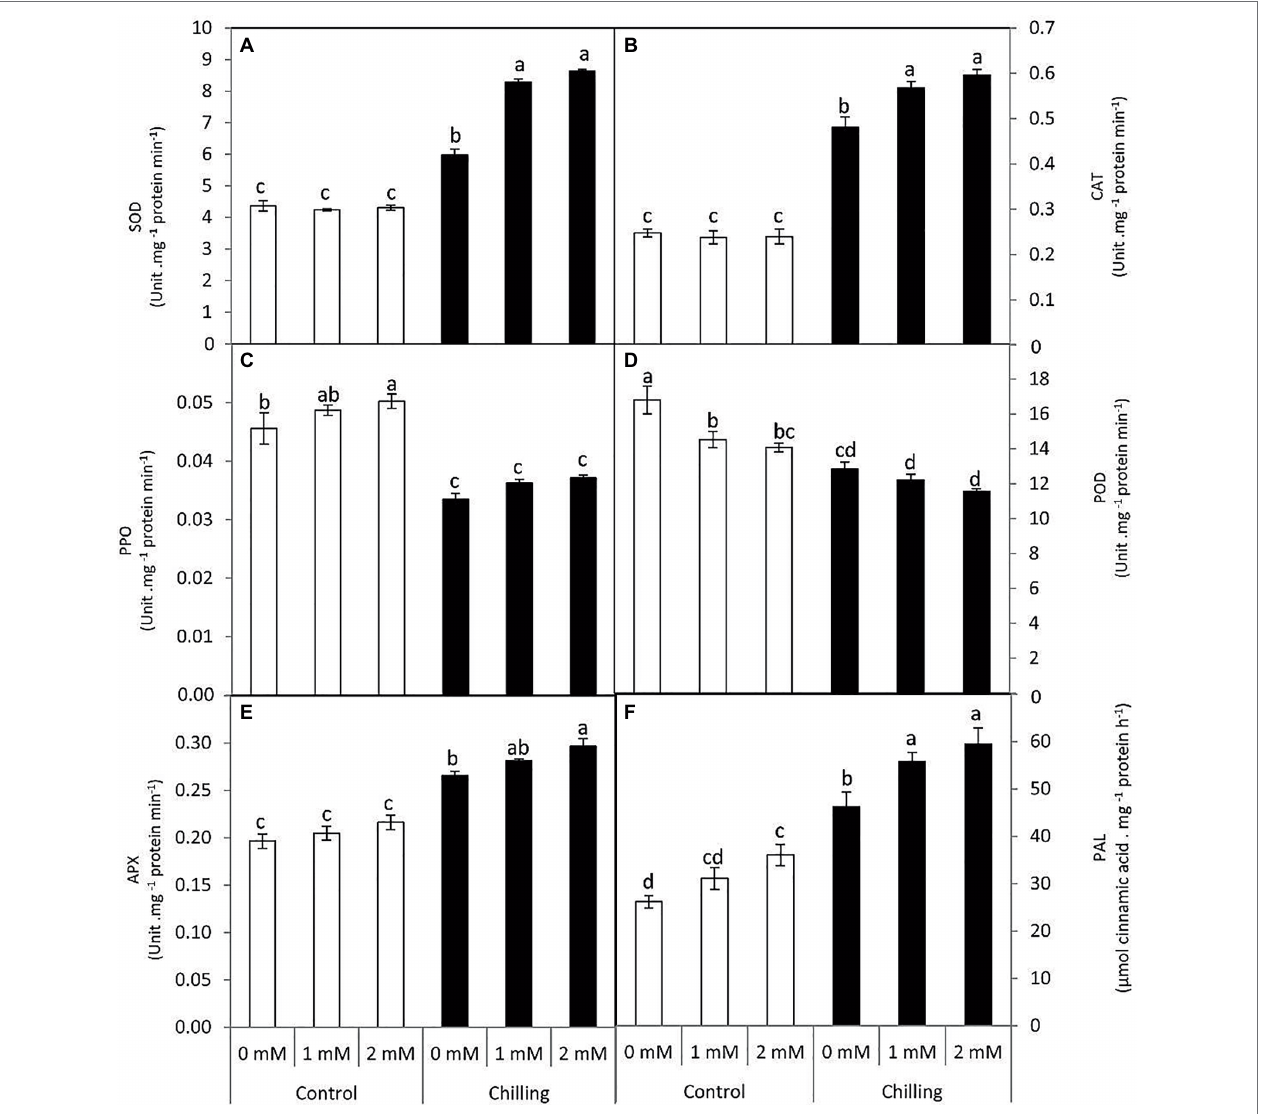
FIGURE 5 | Effect of γ -aminobutyric acid (GABA) as a foliar application at 1 and 2 mM on antioxidant and phenolic-related enzymes of tomato plants cv “Super marmende” growing under normal (25°C/20°C day/night ) and chilling conditions (5 days/4ºC for 6 h/day) followed by 2 days recovery. (A) , superoxide dismutase (SOD); (B) , catalase (CAT); (C) , polyphenol oxidase (PPO); (D) , peroxidase (POD); (E) , ascorbate peroxidase (APX), and (F) , phenylalanine ammonia lyase (PAL). Data followed by the same letters ± SE are not significant according to Duncan multiple rang test at P ≤ 0.05. The white columns refer to the control conditions and the black columns refer to the chilling